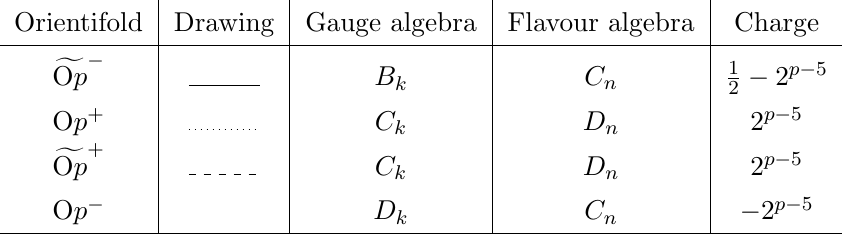
Table 6 . Summary of orientifolds. The gauge algebra is indicated for a stack of k half D p branes on a O p orientifold plane. Whereas the (cid:13)avour algebra is provided for a stack of n half D( p +2) branes perpendicular to